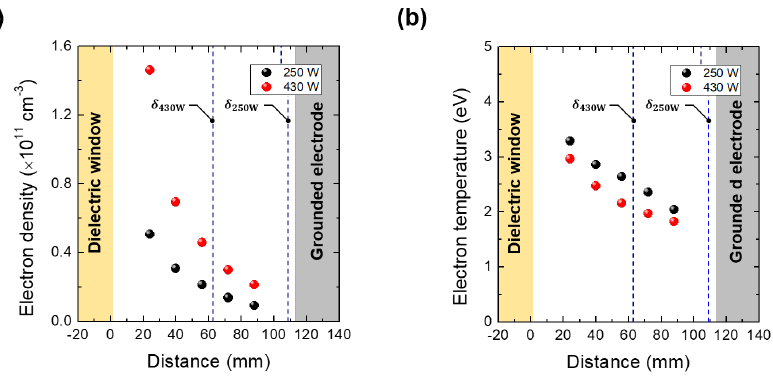
Figure 3. ( a ) Electron density and ( b ) temperature profiles with discharge powers of 250 W and 430 W at 206 mTorr. The average skin depths ( δ 250W of 108.9 ± 14.6 mm and δ 430W of 60.6 ± 8.4 mm) are marked as the dashed